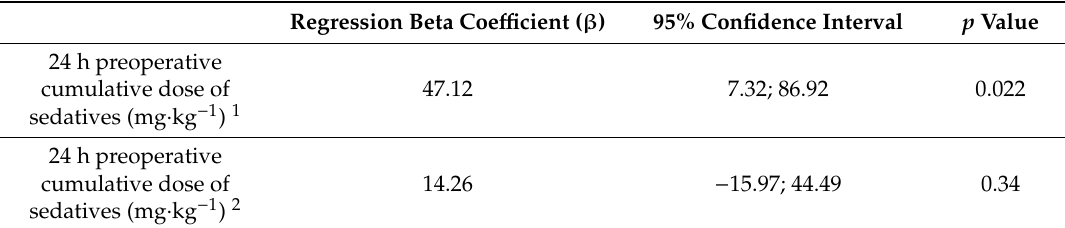
Table 5. Predictive value of the cumulative dose of preoperatively administered sedative agents for the percentage (%) of time of intraoperative hyperoxia FTOE by multivariate 0.75 and 0.5 (median) quantile regression models adjusted for possible confounding